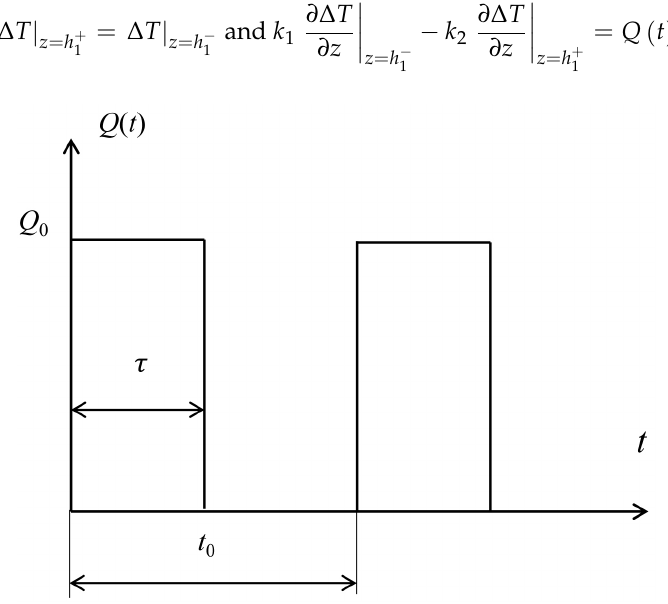
Figure 3. The pulsed power density Q ( t ) with Q 0 as the peak power density, t as the during time and t 0 as the period.